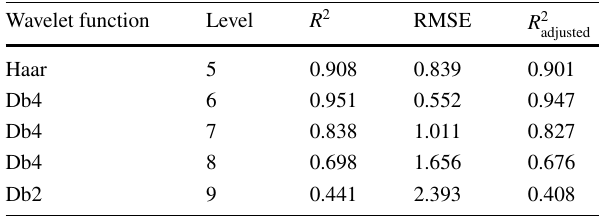
Table 2 Best performance at different levels of decomposing Wavelet function